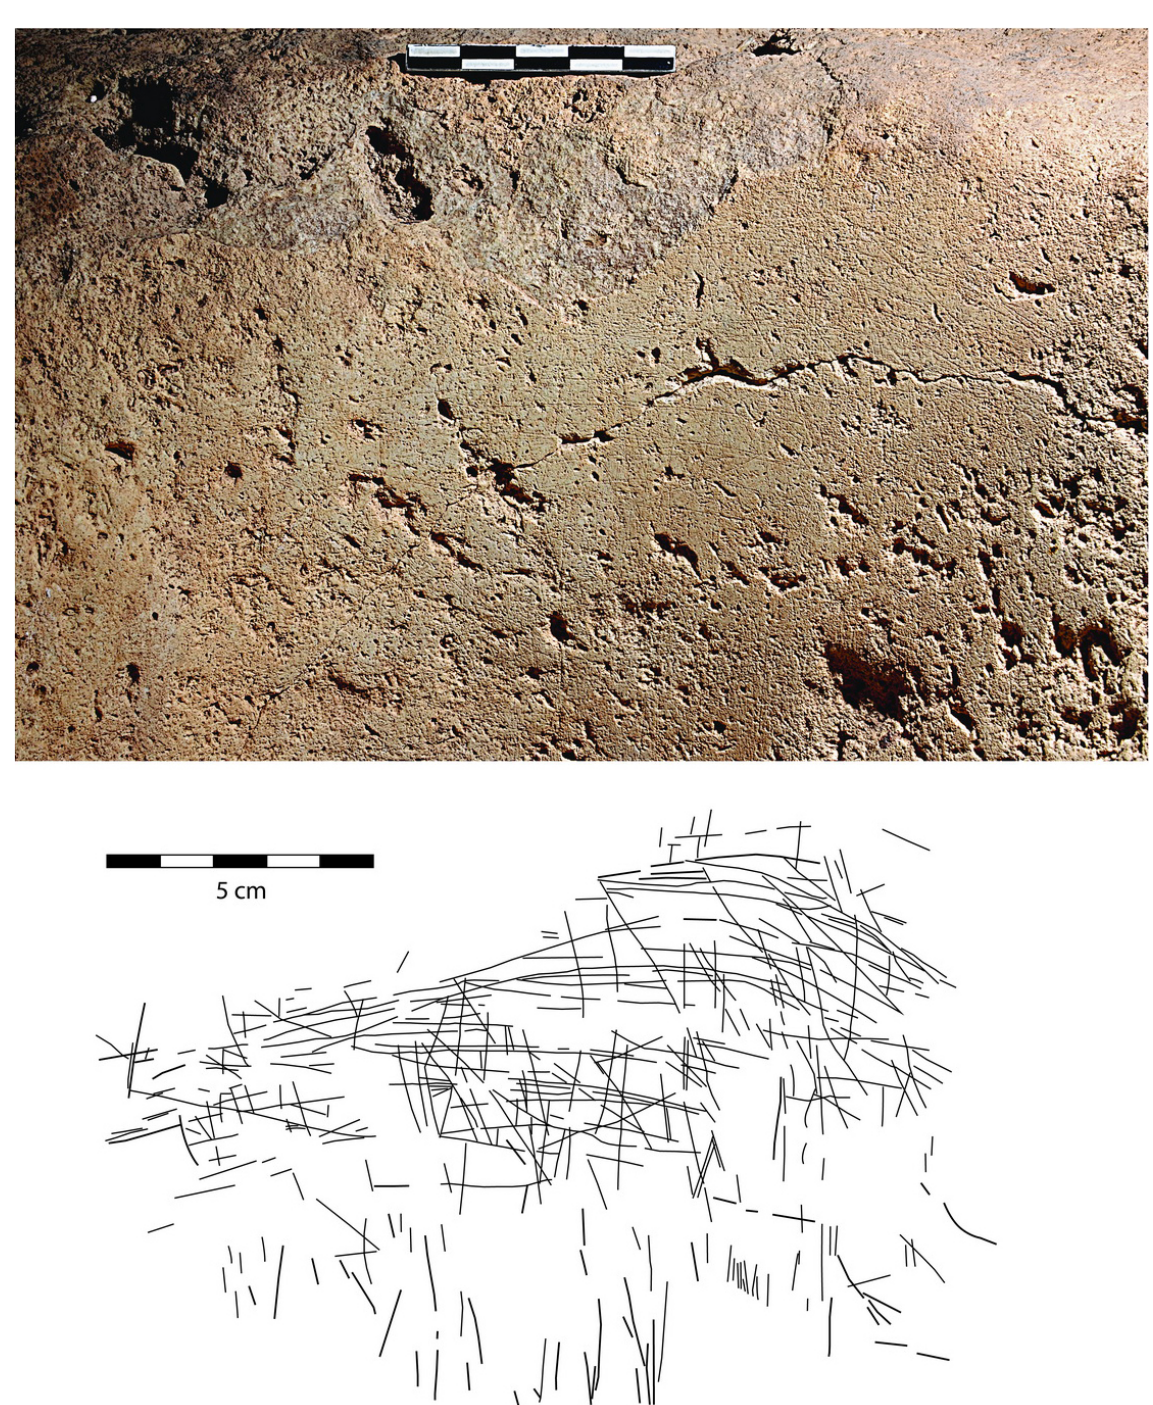
Figure 9. The incised area in photo (top) and tracings (bottom) (photograph by E. Crater